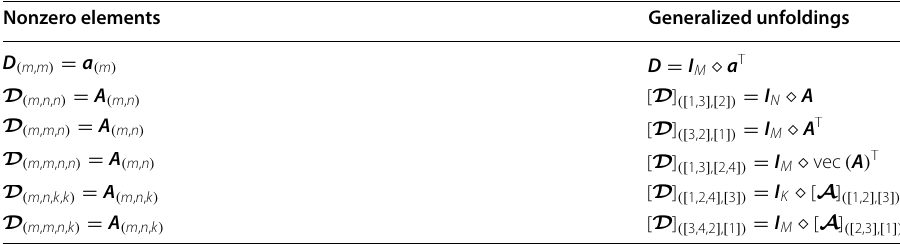
Table 1 Link between the diagonalized tensor structures and their generalized unfoldings Nonzero elements Generalized